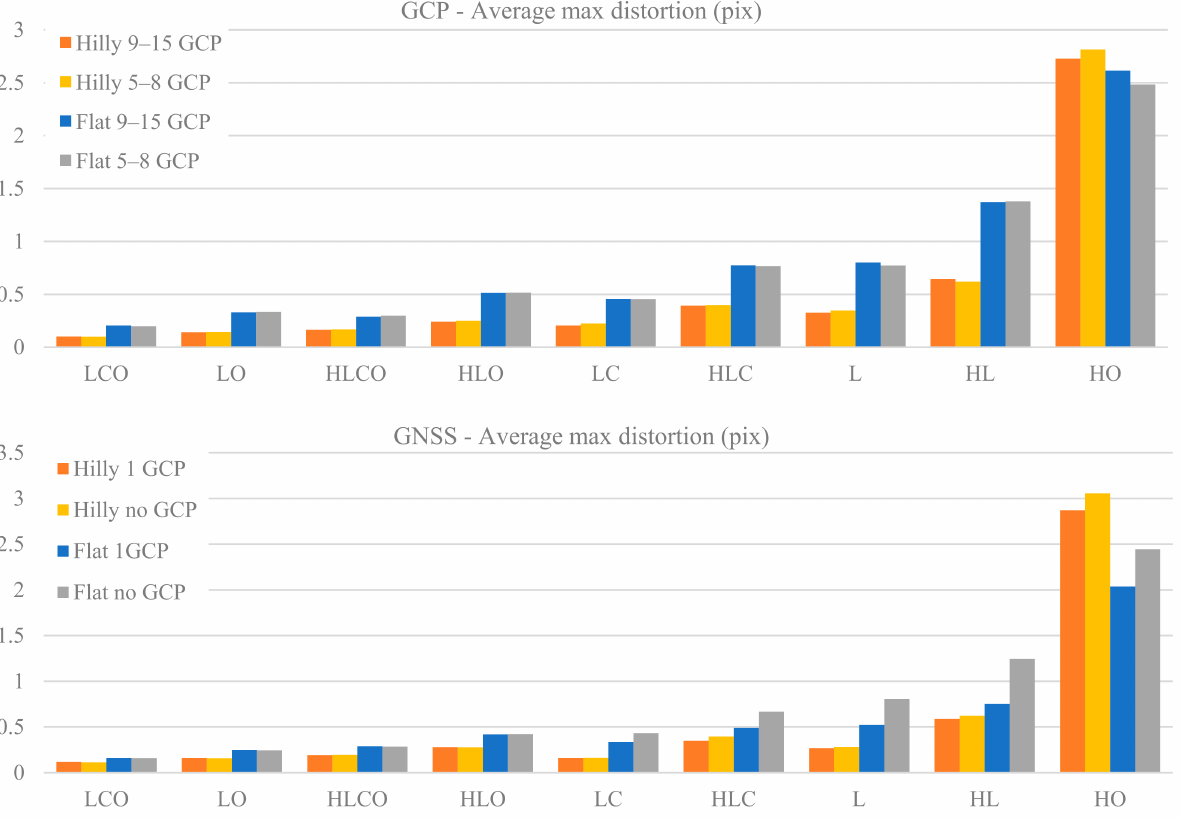
Figure 6. Average value of the maximum distortion error (in pixels) registered over the image frame as a function of the nine cases, of the terrain type (Flat, Hilly) and of the control tightness (Basic or Enhanced), respectively, in the GCP and GNSS